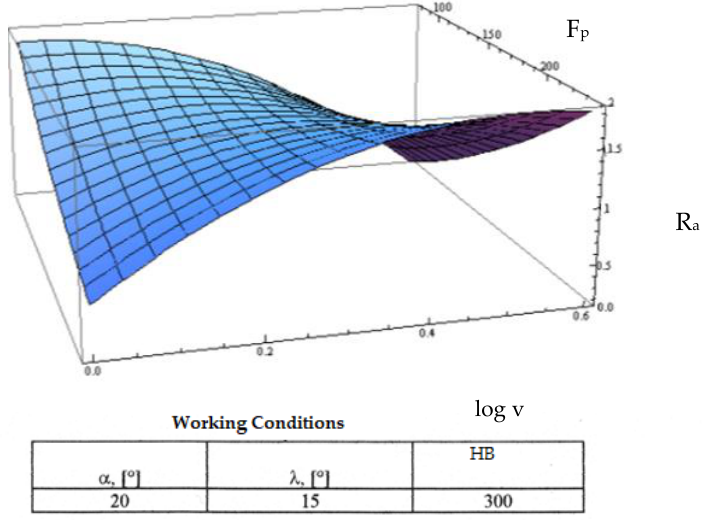
Figure 15. Influence of the cutting speed v and radial force F p on roughness R a .